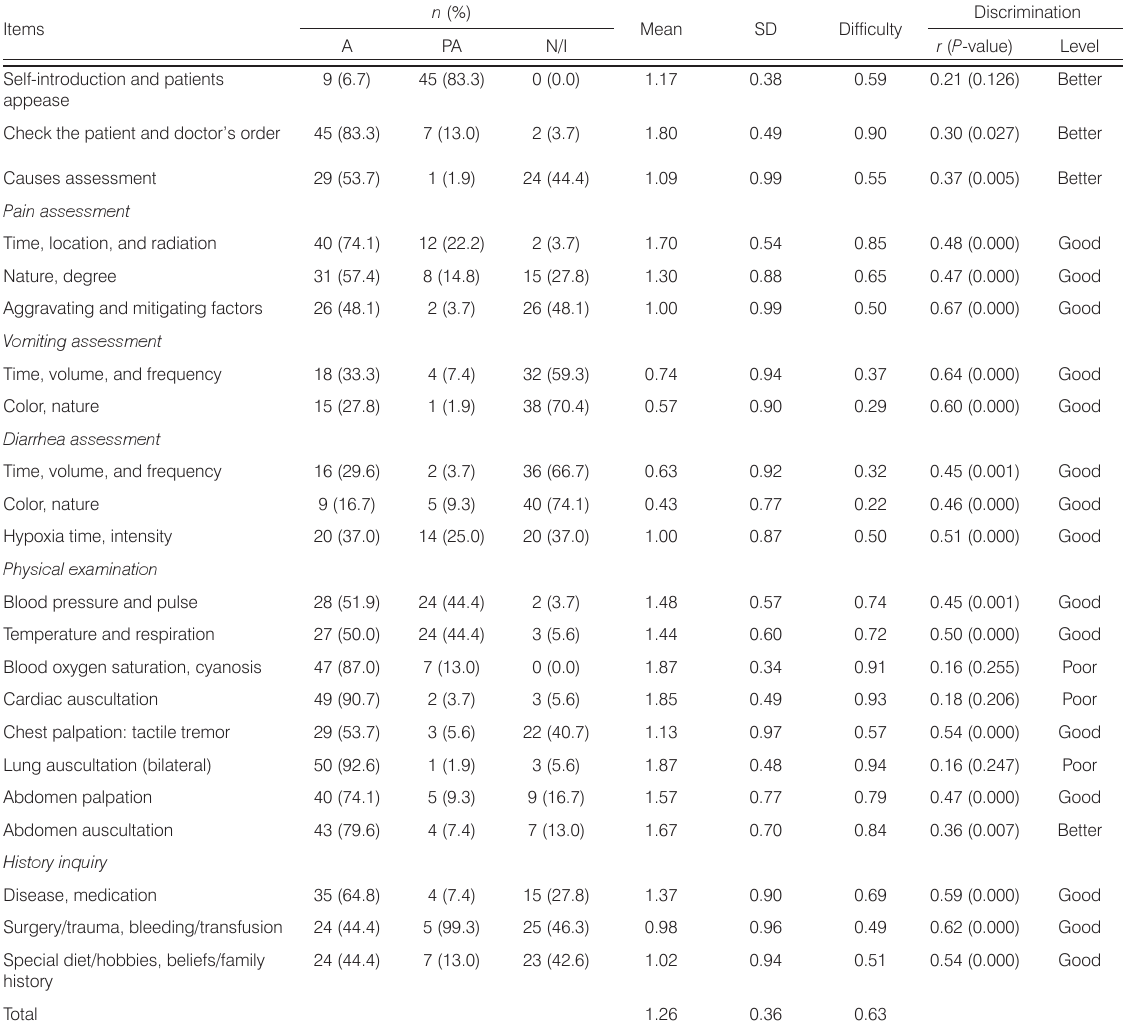
Table 3. Score description of nursing assessment skills in OSCE ( N =